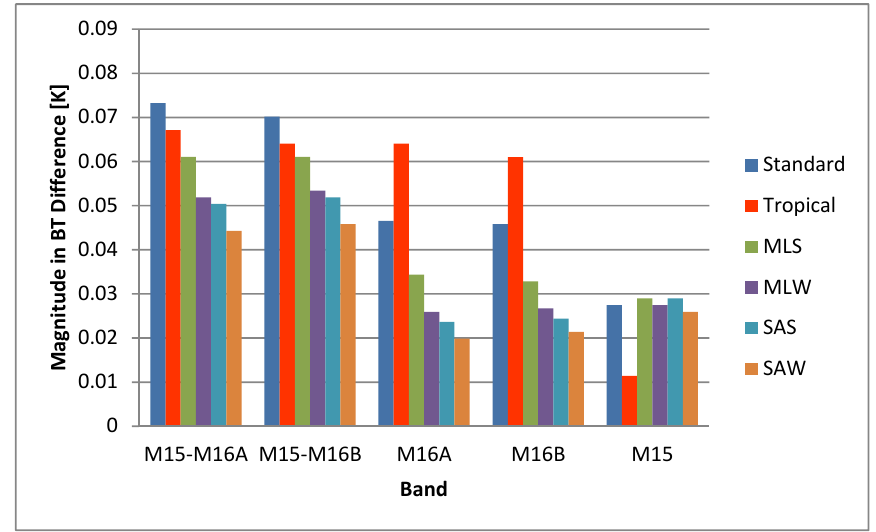
Figure 3. The magnitude of brightness temperature difference (from Equation (4)) between using detector level and band averaged RSR for six LBLRTM atmospheres.